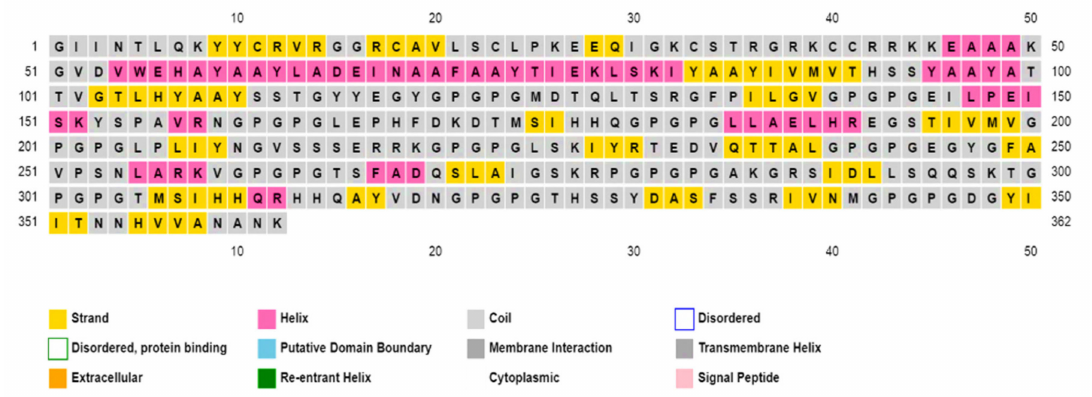
Figure 3. Distribution of secondary structure elements of the proposed immunogenic construct. Alpha-helices are shown as magenta, coils as grey, and beta sheets as yellow color. The other regions were not predicted as a part of immunogen construct.